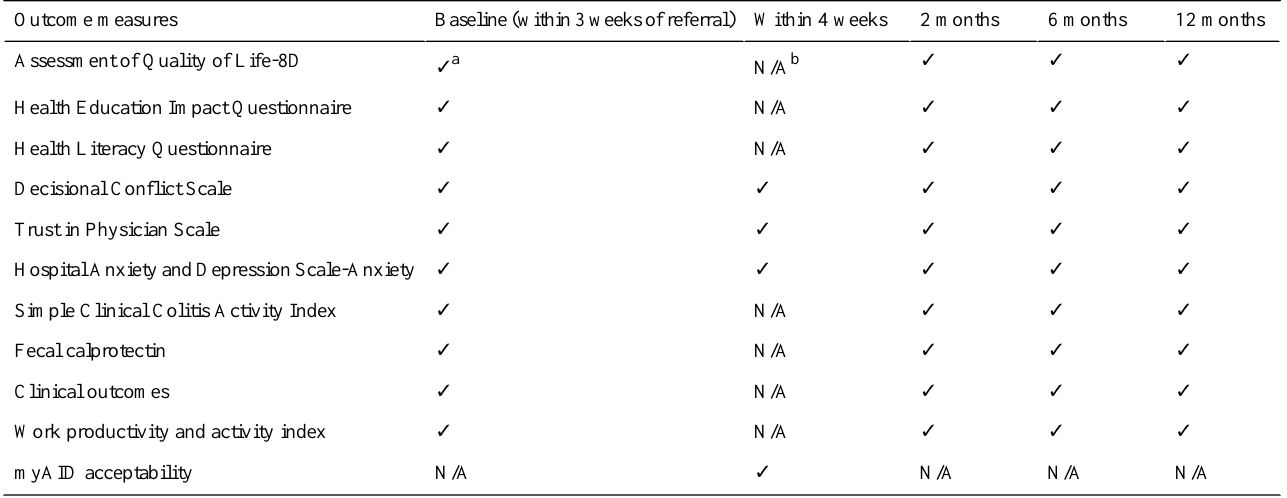
Table 1. myAID study outcome